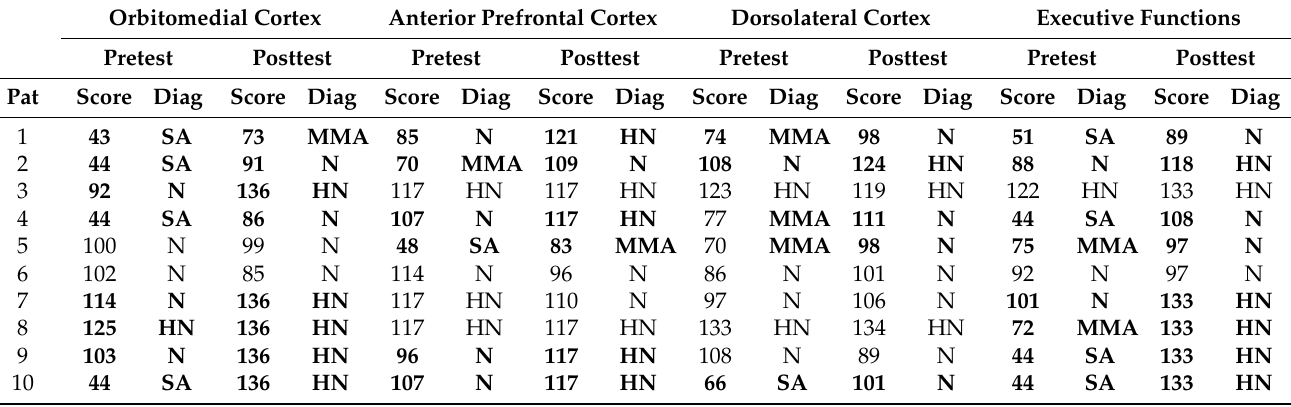
Table 3. Scores and diagnostics of the neuropsychological executive functions battery in LEGO ® - based therapy patients with congenital heart